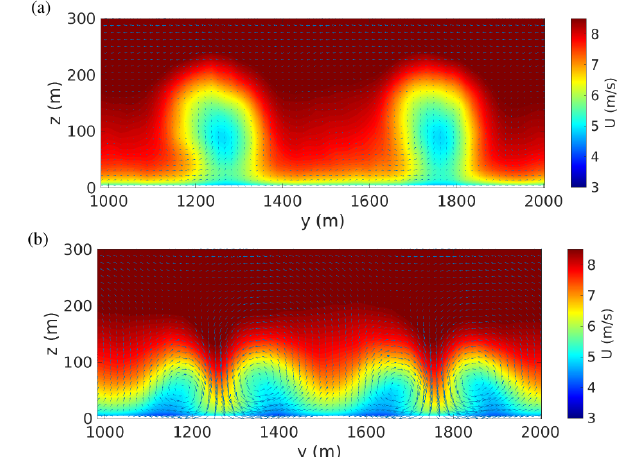
Figure 4. Time-averaged streamwise (color scale) and cross-stream (arrows) velocity fields in the cross-stream plane at x = 2000m in the region corresponding to the wake of the two central (in the span- wise direction) turbines of the middle turbine row (same case as in Fig. 3). (a) The reference case where two (low-speed) wakes are clearly visible. (b) The controlled case with ϕ = 30 ◦ where high- speed streaks have replaced the wakes which have been displaced towards the ground and then to the sides.